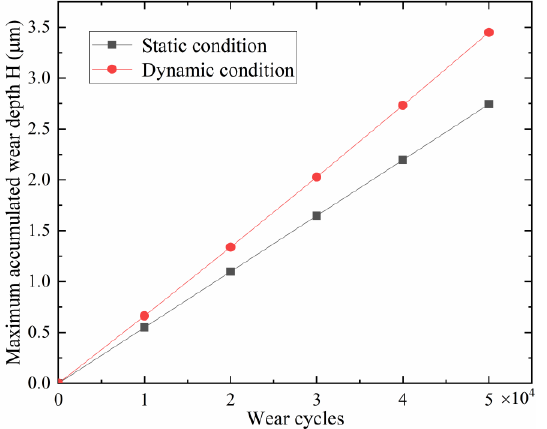
Figure 13. Maximum accumulated wear depth of a pinion under different conditions.